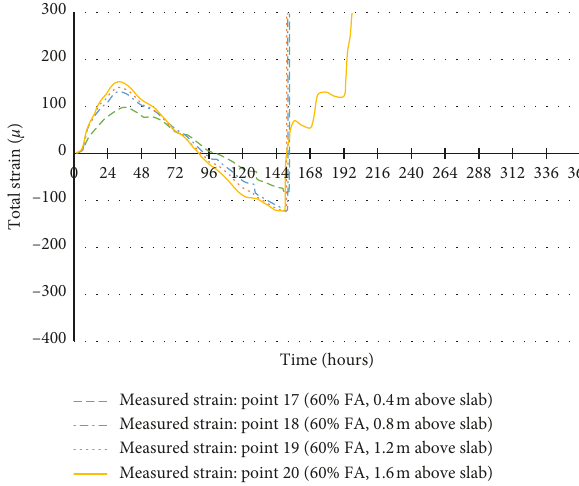
Measured strain: point 17 (60% FA, 0.4m above slab) Measured strain: point 18 (60% FA, 0.8m above slab) Measured strain: point 19 (60% FA, 1.2m above slab) Measured strain: point 20 (60% FA, 1.6m above Figure 8: Measured total strain development in the 5.0m section of low-heat